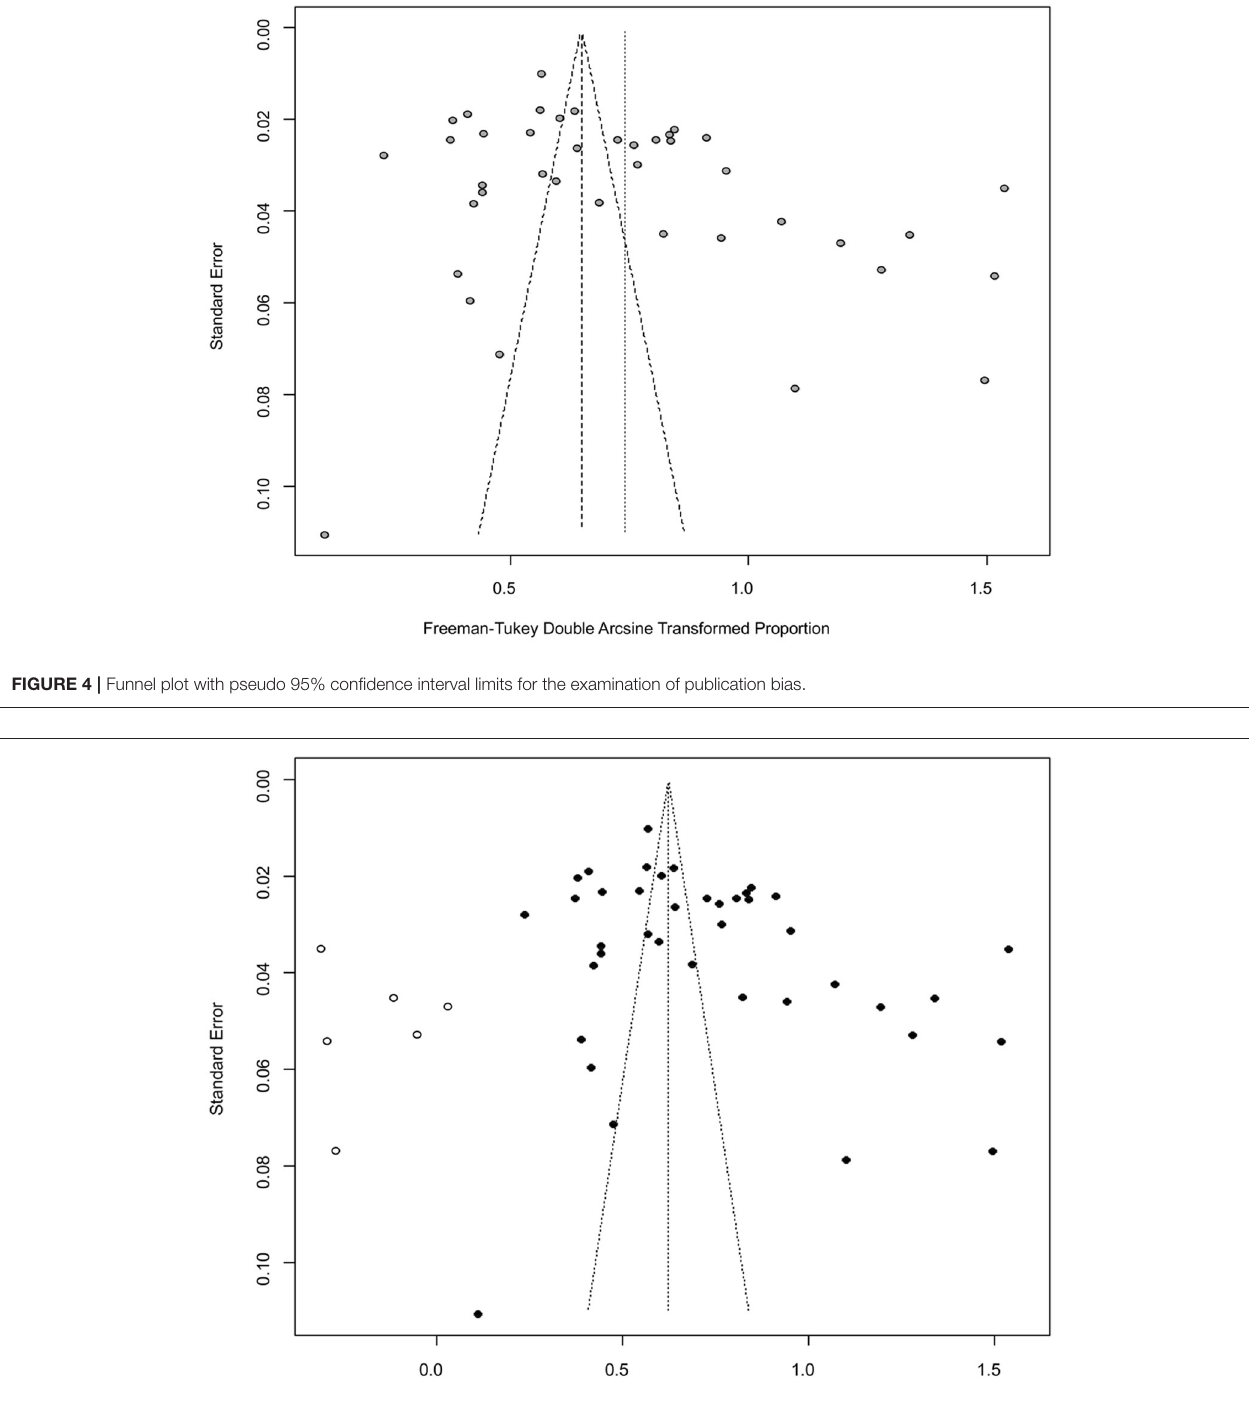
studies demonstrated that the distribution of Anisakis spp. and the infection levels in the same fish species varied among different fishing grounds (15,